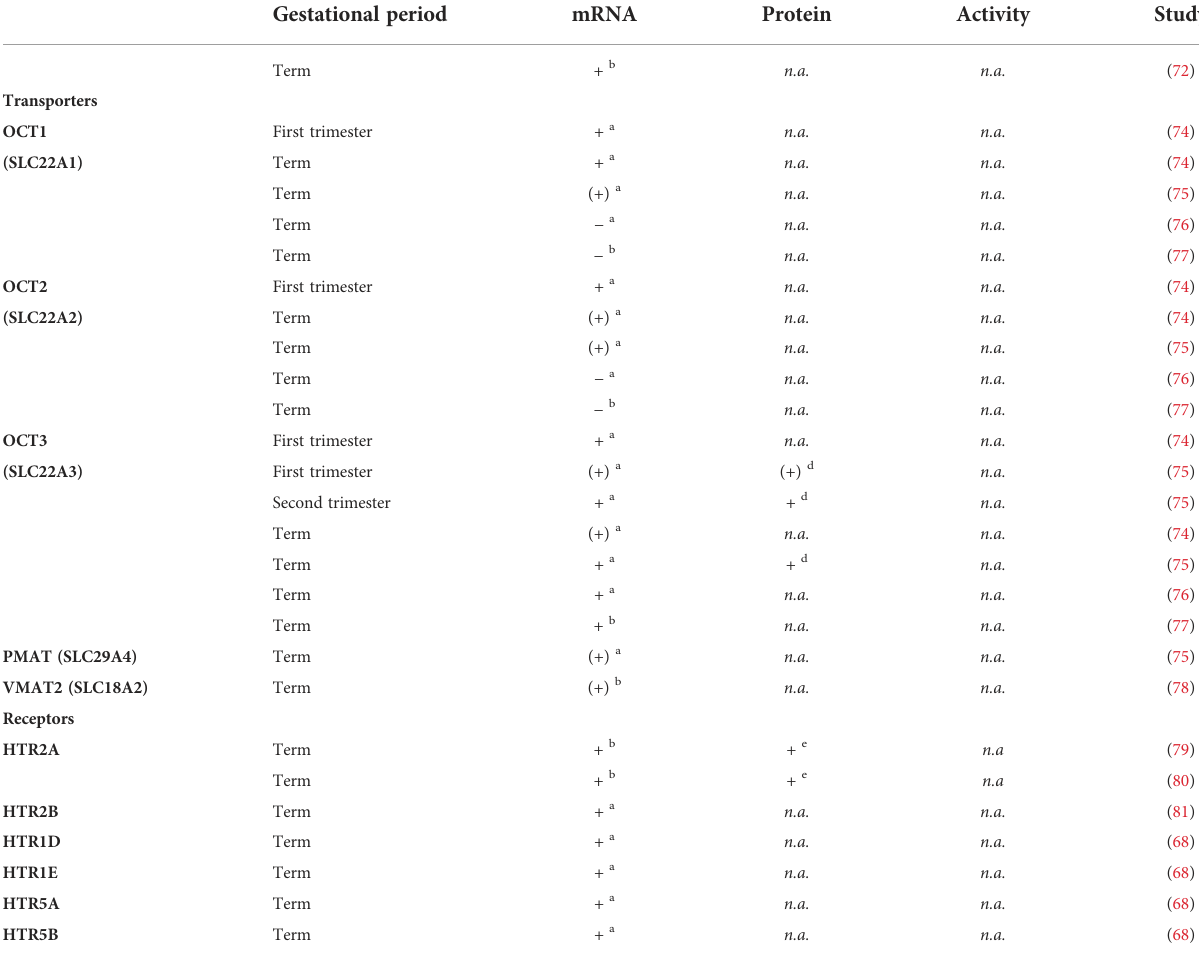
Western blot. f ELISA (enzyme-linked immunosorbent assay). g